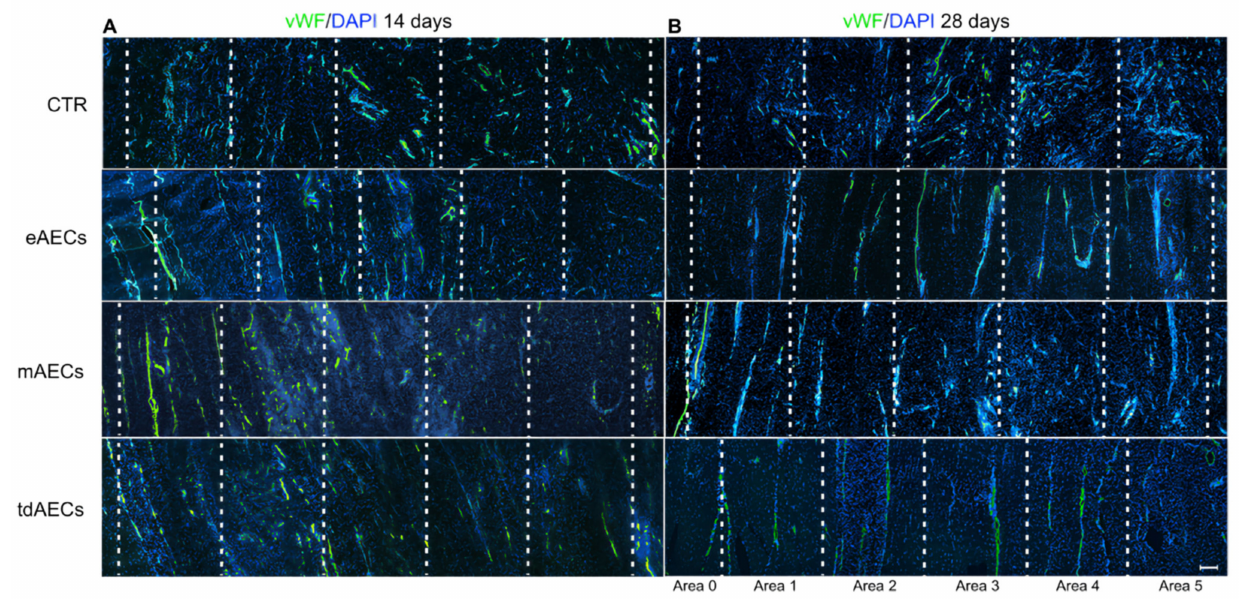
Figure 11. Tendon vascularization within CTR and treated tendons. Blood vessel distribution is docu- mented in CTR and eAEC-, mAEC- and tdAEC-treated tendons at day 14 by immunohistochemistry using the endothelial marker, vWF (green fluorescence). Nuclei were counterstained with DAPI. In each panel the healthy portion (area 0 positioned on the left in all images) and the injured area of CTR and treated explants (from area 1 to area 5) are shown. Allotransplanted tendons displayed: ( A ) at day 14 the presence of blood vessels that were either scattered or aligned to the longitudinal axis of the tendon for an extension corresponding to maximum 1 area within the injured site and ( B ) at day 28, a limited number of blood vessels within the lesion; most of them ran parallel to the longitudinal axis of the tendon, similarly to those observed in the healthy portion of the explant, for an extension corresponding to up to 4 areas within the injured tendon. A more irregular organization was observed in the blood vessels localized in the core of the defect. ( A , B ) CTR tendons showed blood vessels irregularly distributed in the entire injury site. Scale bar = 100 µ